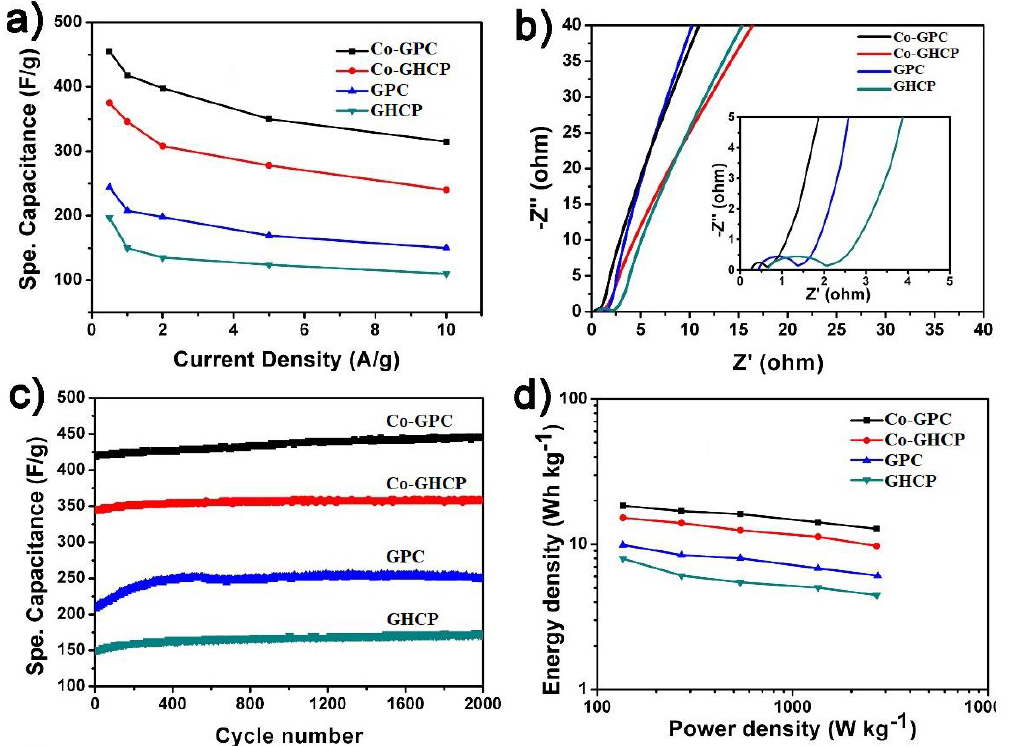
Figure 6. ( a ) Specific capacitance of the Co-GHCP, Co-GPC, GHCP, and GPC. ( b ) Electrochemical impedance spectroscopy (EIS) plots of the Co-GHCP, Co-GPC, GHCP and GPC, Inset: the low frequency region; ( c ) Cycling performance of the Co-GHCP, Co-GPC, GHCP, and GPC at the specific currents of 1 A g − 1 ; ( d ) Ragone plot of the Co-GHCP, Co-GPC, GHCP, and GPC.